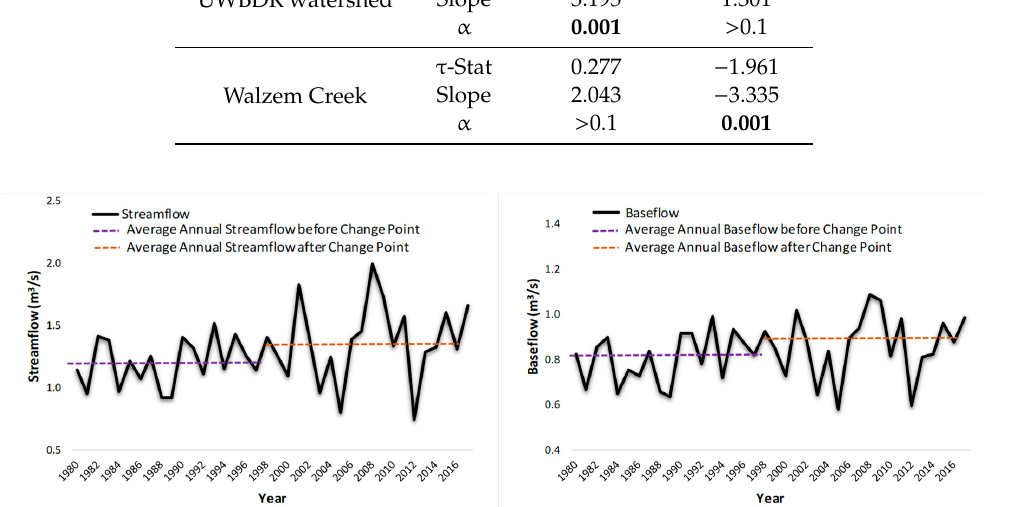
Table 3. Temporal trends in annual streamflow and baseflow in the study areas.